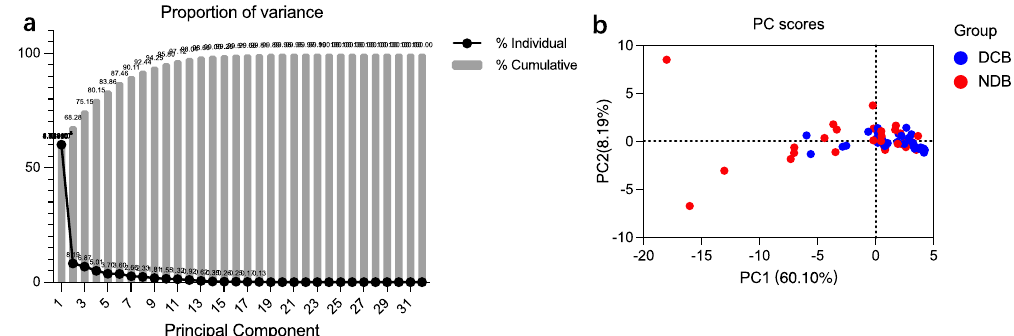
Figure 2. Principal component analysis of full feature signatures. ( a ) Figure of PCA value and cumulative variance contribution rate. Six main principal components were obtained from 32 features (including 6 clinical features and 26 radiomics features), and the cumulative variance contribution rate achieved 87.64%. ( b ) PCs scores of PC1 and PC2 in DCB group (blue dots) and NDB group (red dots).